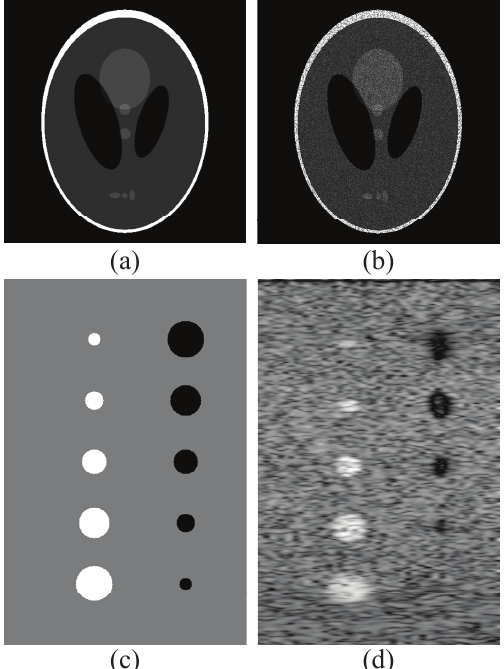
Figure 5. Illustration of synthetic images with speckle noise added by different methods. ( a , c ) are two clean images. ( b ) is a noisy image of ( a ), with multiplicative Gaussian noise (with δ s = 0.3) added, and ( d ) is a noisy image of ( c ) with speckle noise added using the Field II toolbox